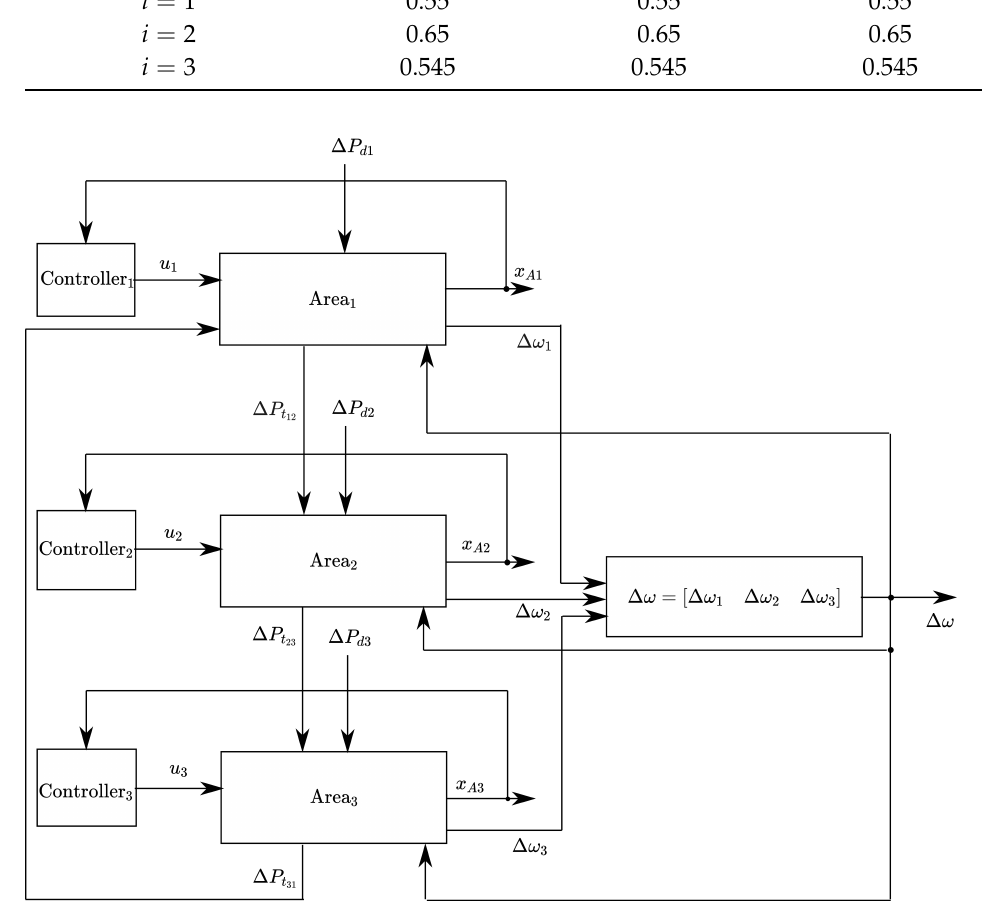
Figure 2. The block diagram of the control of three-area power generation